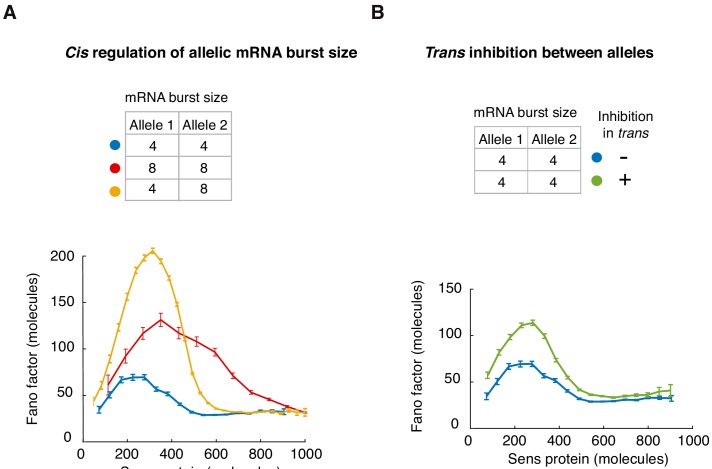
Fano factor profiles from model simulations in which sens alleles at 57F5 are regulated independently in cis or there is promoter inhibition in trans.(A) In order to mimic a cis-only mode of regulation, one set of simulations was run with an average burst size (Sm/koff) of 4 mRNAs (blue). Another set of simulations was run with an average burst size of 8 mRNAs (red). We assumed these different burst sizes corresponded to 22A3 and 57F5 alleles, respectively. For each set, the kon rate parameter was systematically varied to generate simulations with a range of steady-state protein output. To mimic cis-only regulation in 57F5/22A3 cells, each allele’s expression in the virtual cell was simulated independent of the other allele. This was done by simulating an average burst size of 4 mRNAs for one allele and 8 mRNAs for the other allele (yellow). Thousands of such cells were simulated for each value of kon and then binned according to total protein output. Fano factor of bins is plotted for each virtual allelic combination. (B) To simulate inhibitory interactions between paired 57F5 alleles (green), the kon of one allele was downregulated by 90% if the other allele was turned on to transcribe, and vice-versa. Non-interacting alleles (blue) were simulated independent of each other as in (A). Both sets of simulations were run with average burst size of 4 mRNAs. Thousands of cells were simulated across a spectrum of kon rates. Fano factor for binned cell populations is plotted. All error bars are 95% confidence intervals.